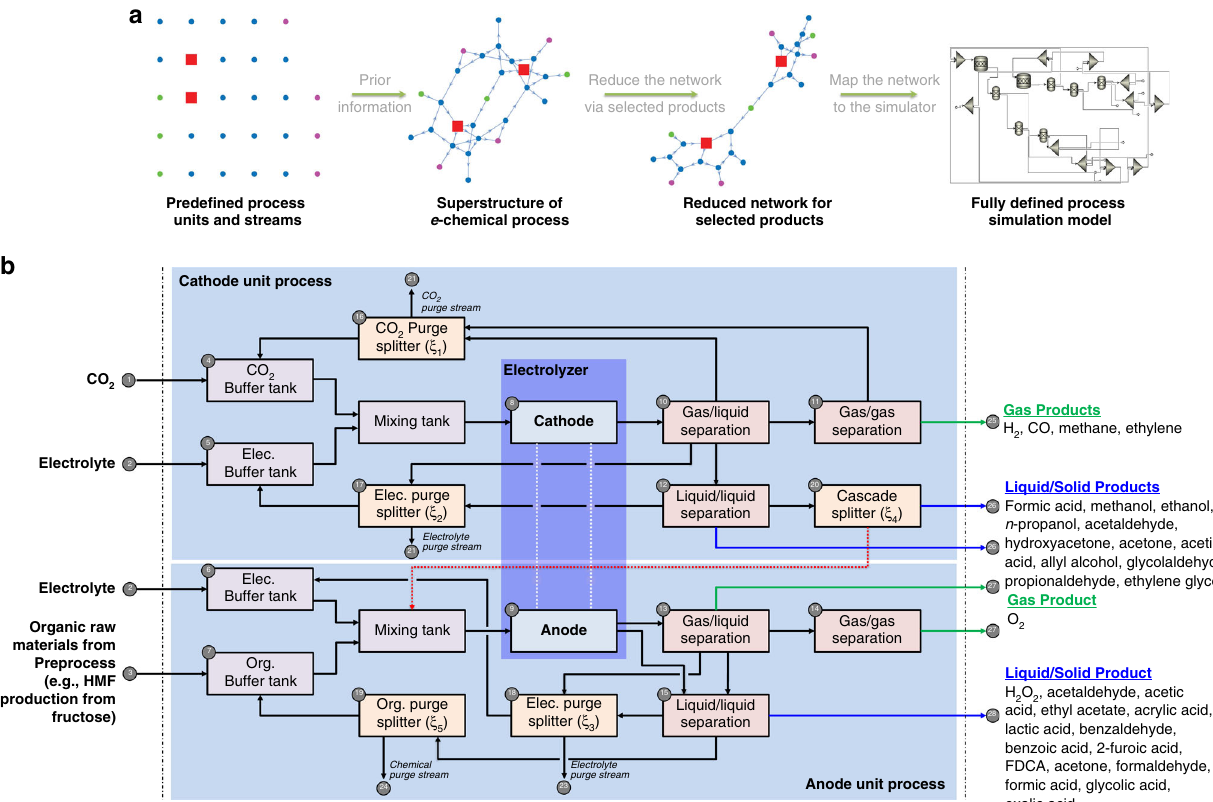
Fig. 3 Automated and generalized platform for the technoeconomic analysis. a Schematic diagram of how the automated platform reduces the process structure and generates the simulation model. b Superstructure of the electrochemical coproduction process used to simultaneously consider all possible structures of the